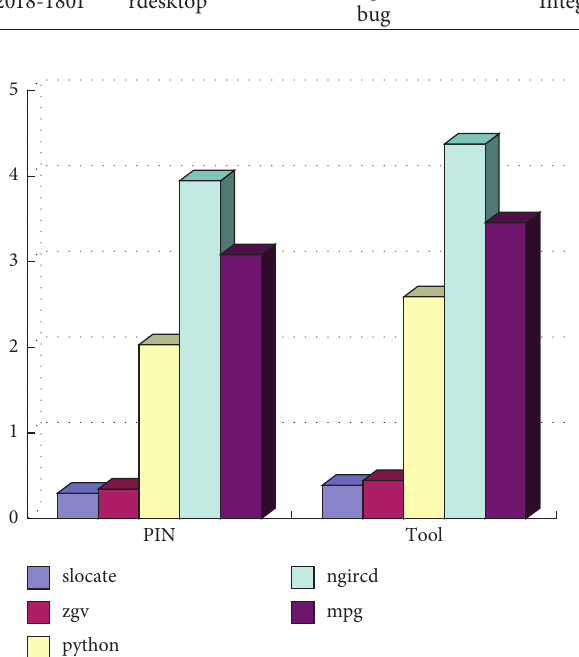
Figure 6: Performance overhead of dynamic detection